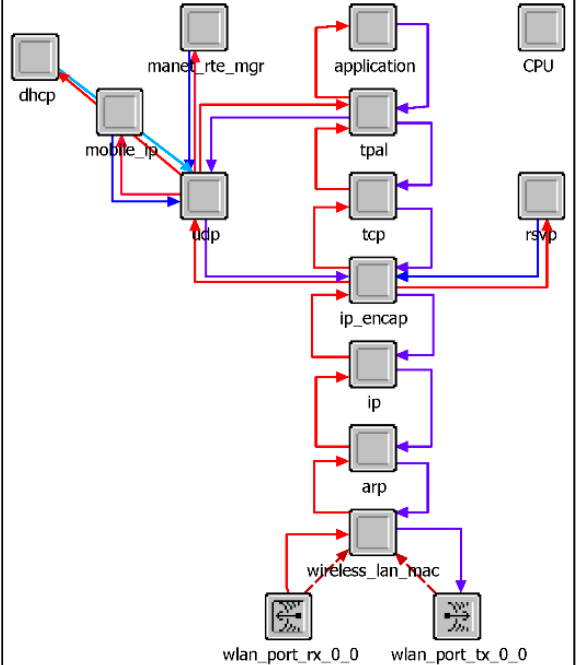
Figure 4. OPNET simulation environment [25].